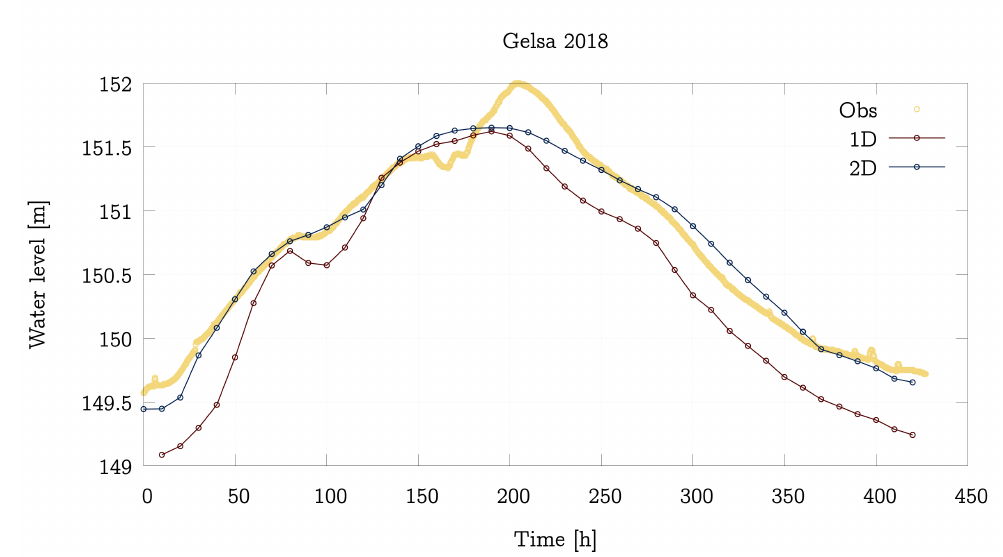
Figure 11. Water level temporal evolution comparison between the 1D model, the 2D model and the observation in Gelsa (A263) gauging station for the 2018